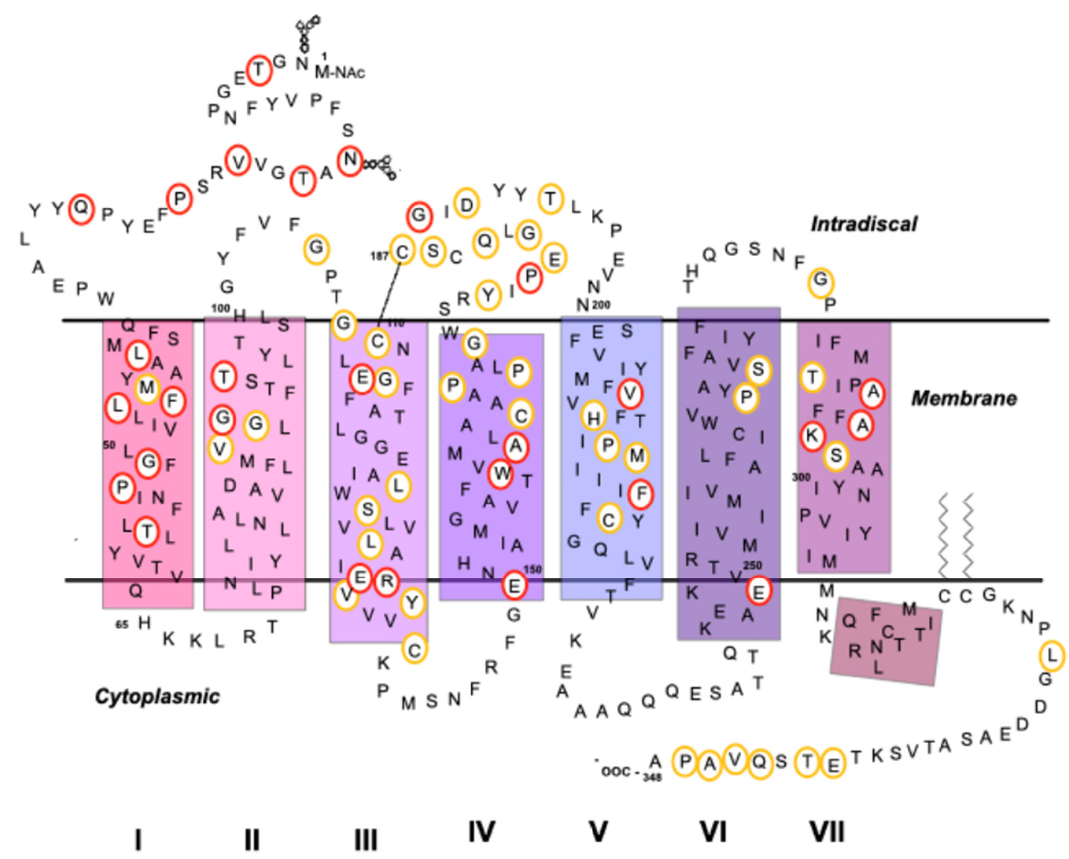
Figure 3. Secondary structure schematic model of Rho, showing amino acids that are sites where mutations associated with RP in patients are found. Sites of RP mutations are circled and those specific positions corresponding to mutations mentioned in the text are circled in red.